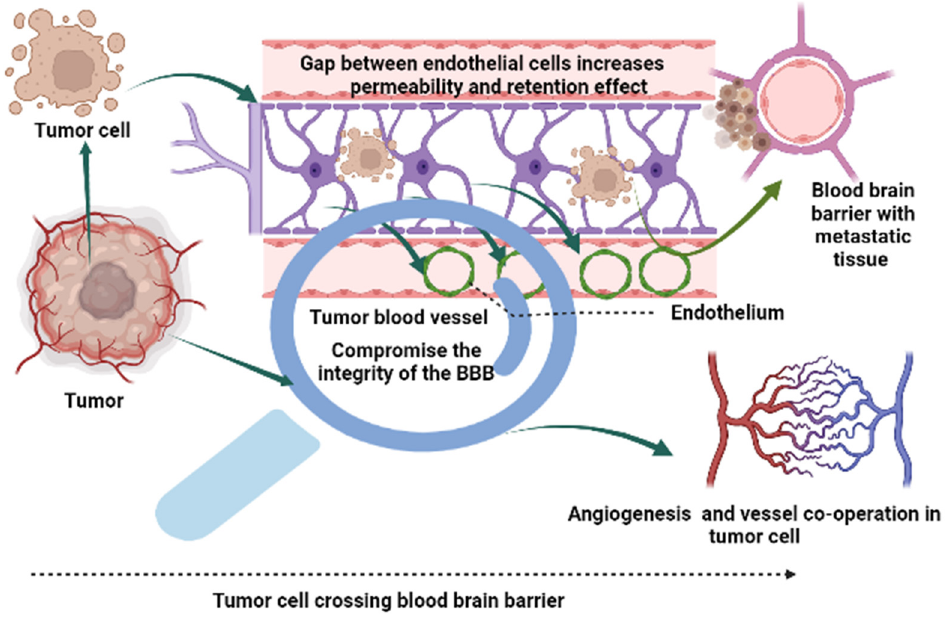
Figure 2. An illustrative image depicting the blood-brain barrier and blood-tumor barrier.